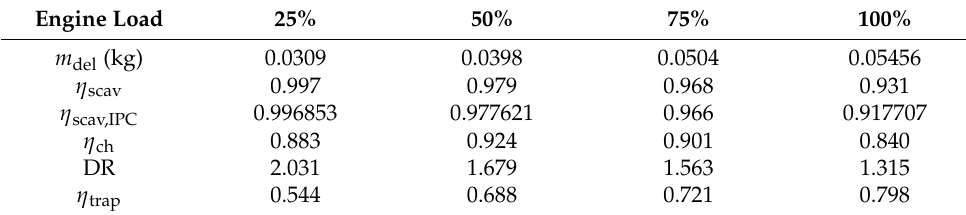
Figure 9. The variation of angular momentum over time for different engine loads. Table 5. Scavenging parameters for different engine loads.